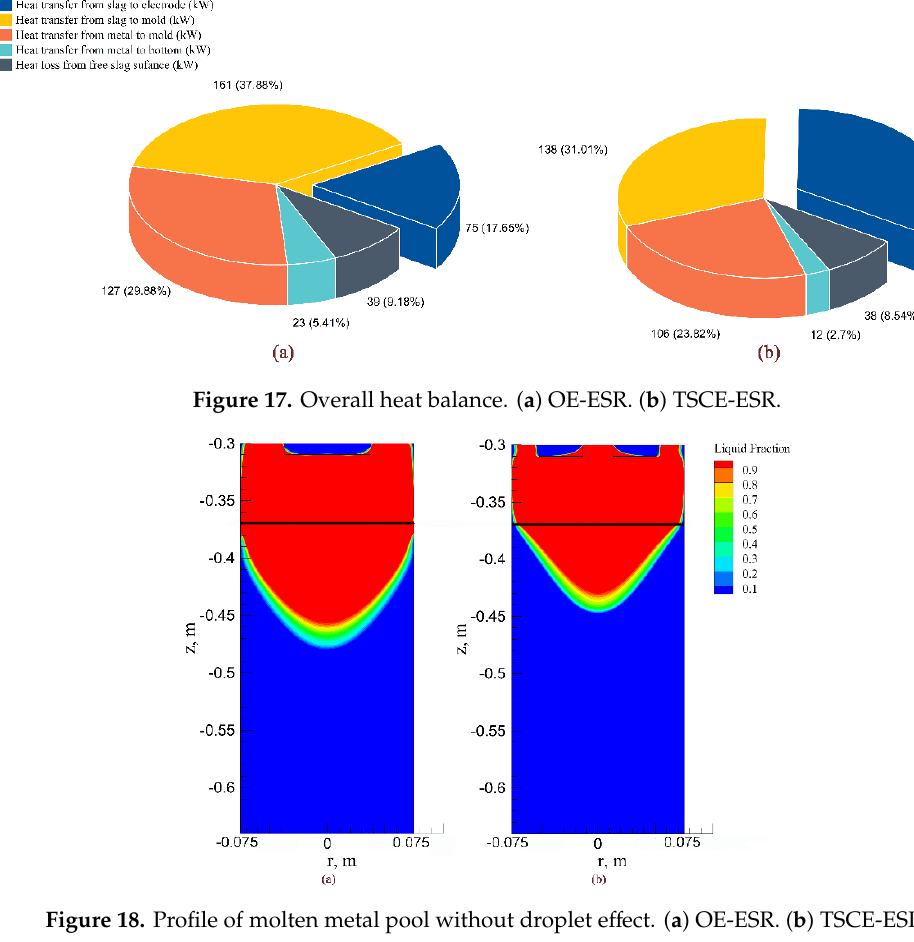
Figure 18. Profile of molten metal pool without droplet effect. ( a ) OE-ESR. ( b ) TSCE-ESR.